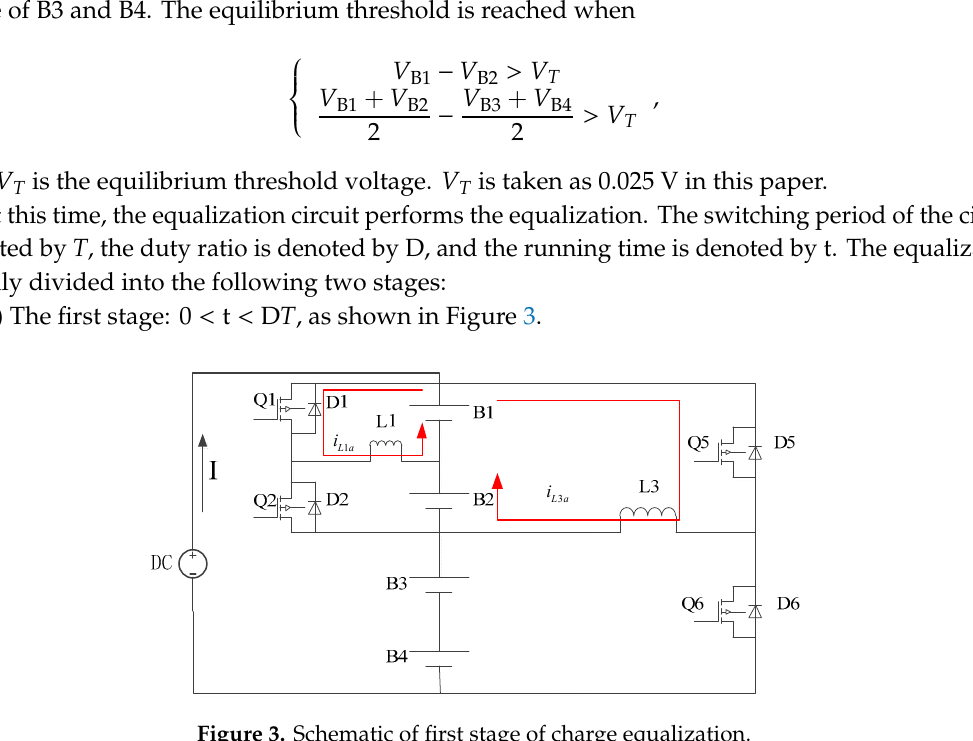
Figure 3. Schematic of first stage of charge equalization.